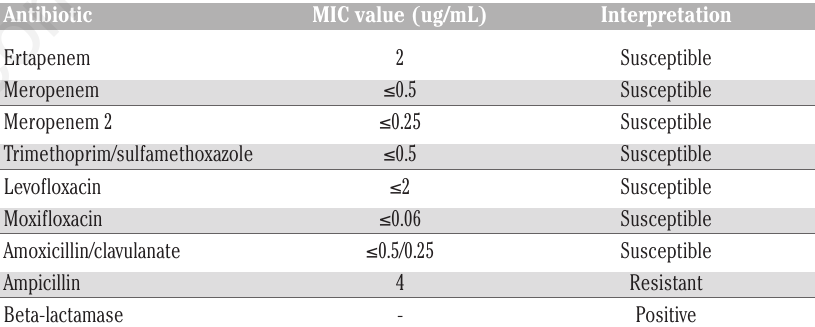
Table 1. Antibiotic susceptibilities of C. hominis.